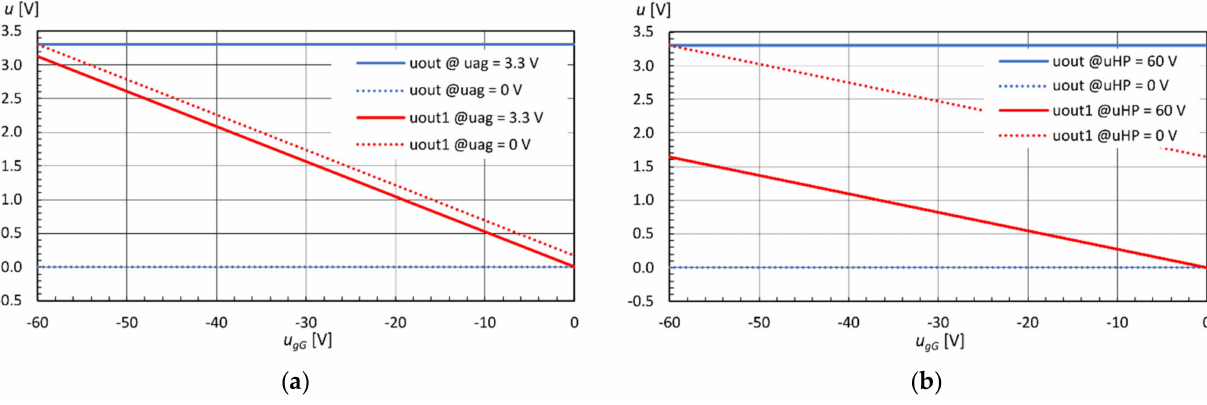
Figure 9. Two-stage circuit outputs ( u out and u out 1 ) for limit input values vs. u gG for measurement of: ( a ) u ag ; ( b ) u HP